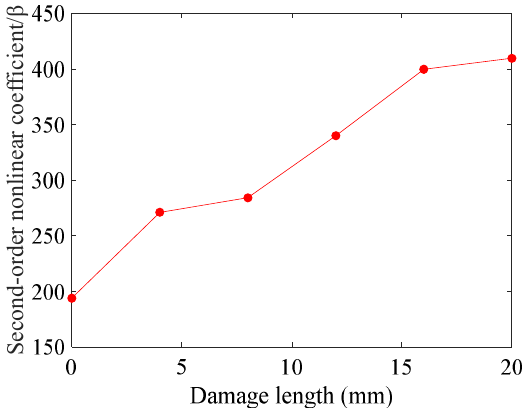
Figure 10. Hilbert marginal spectrum processed by WPT+HHT of different delamination damages.